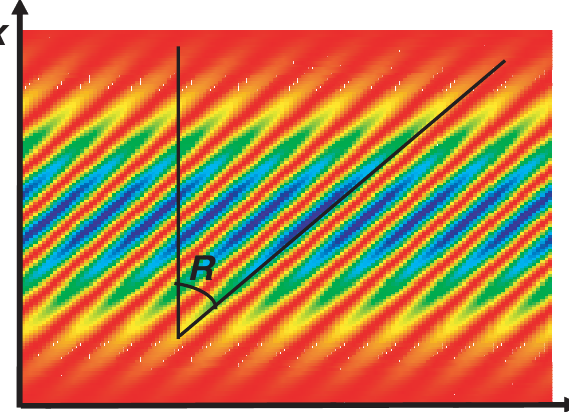
FIG. 13. (Color) A bunch with its density modulation tilted in the x - z plane. The tilt angle is denoted as R , and the bunch head is to the right. Blue represents higher density region and red represents lower density